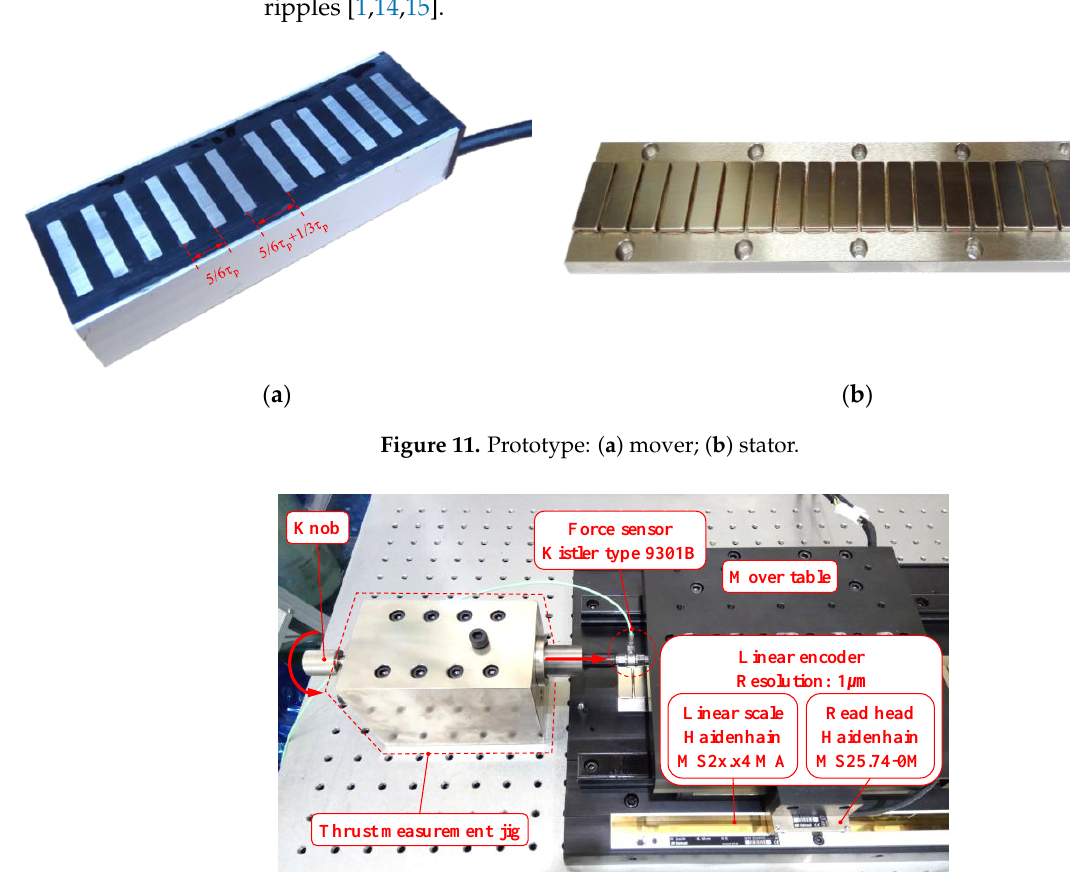
Figure 12. Test setup for thrust measurement.